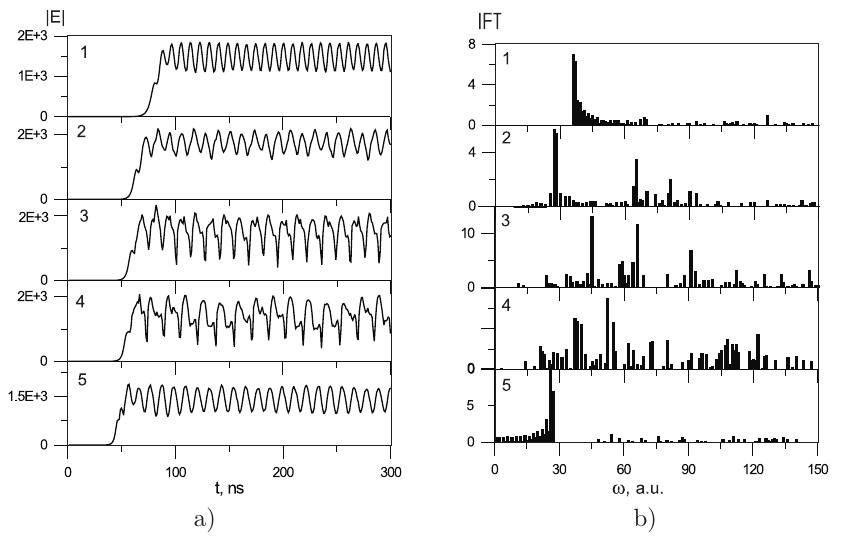
Figure 2. Transition between different regimes of VFEL intensity (a) and corresponding phase space portrait (b) for resonator length L equal to (1) 16 cm, (2) 18 cm, (3) 19 cm, (4) 21 cm and (5) 23 cm for j = 2000 A/cm 2